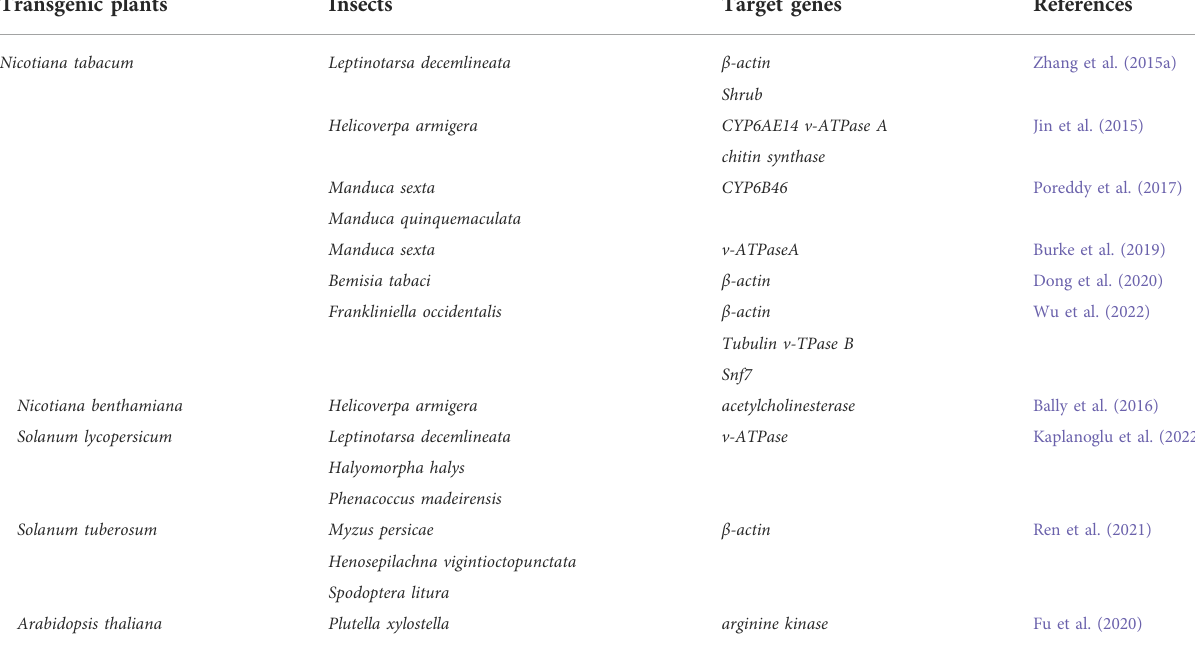
TABLE 2 Plastid transformation-mediated dsRNA-expressing transgenic plants in pest